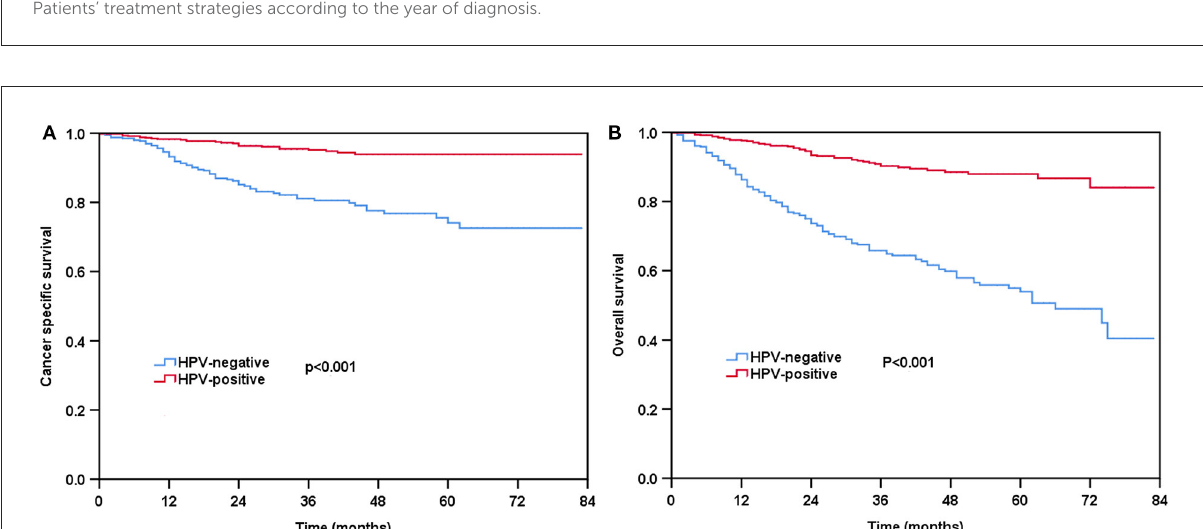
FIGURE2 Kaplan-Meier plots of cancer-specific survival (A) and overall survival (B) by HPV status before propensity score matching